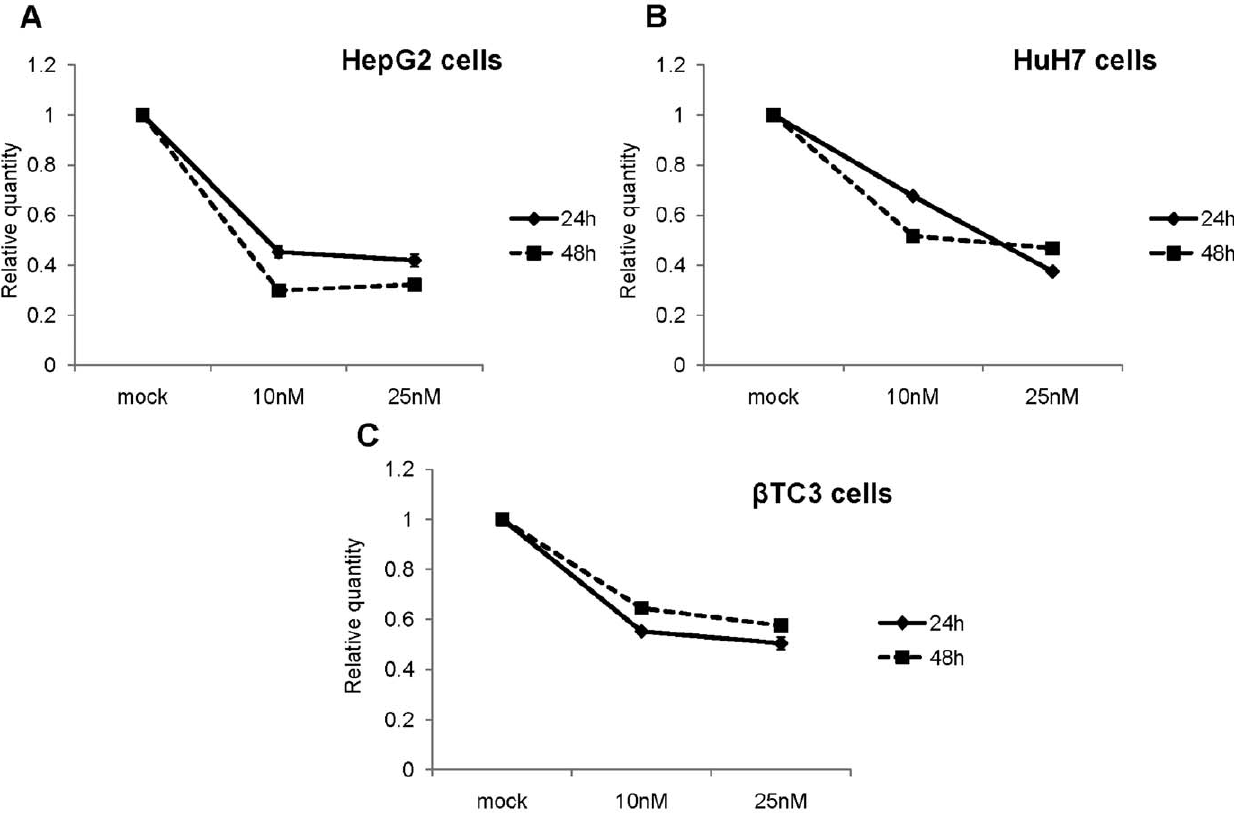
Figure 1. Intracellular reduction of targeted PCSK9 mRNA by LNA ASO. Two human hepatic cell lines: HepG2 and HuH7 and a mouse insulinoma b -TC3 cell line; were transfected with LNA ASO, at concentrations of 10 and 25 nM. Total RNA was extracted at two different time points- 24 h and 48 h post transfection and QPCR analysis was performed using specific primers. The levels of PCSK9 mRNA were normalized to S14 mRNA for (A) HepG2 and (B) HuH7 cells; and (C) with S16 mRNA for b -TC3 cells.